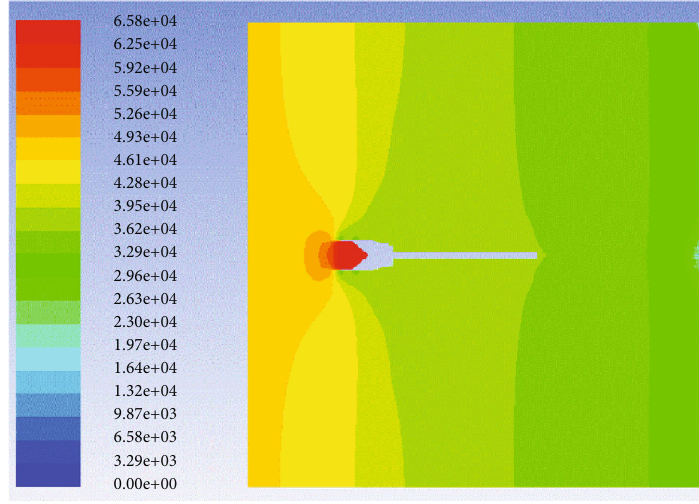
Figure 12: Pressure contour when v = 45 m / s , α = 0 ∘ .